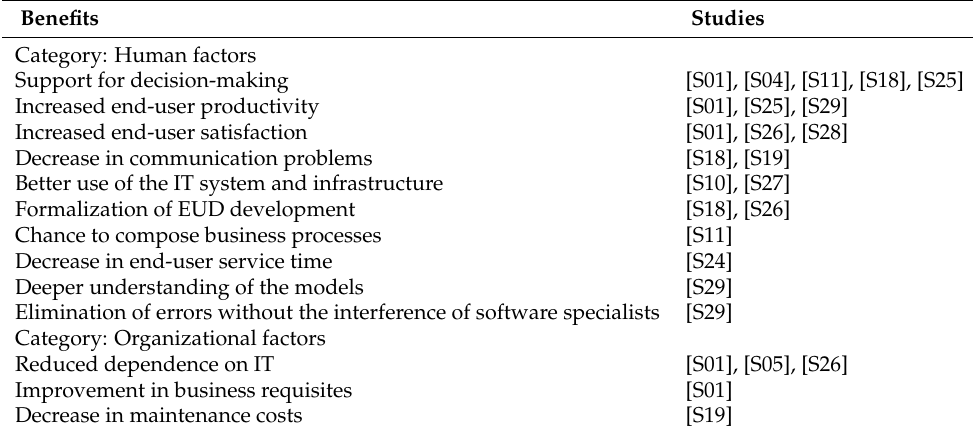
Table 6. Benefits obtained with the adoption of end-user development